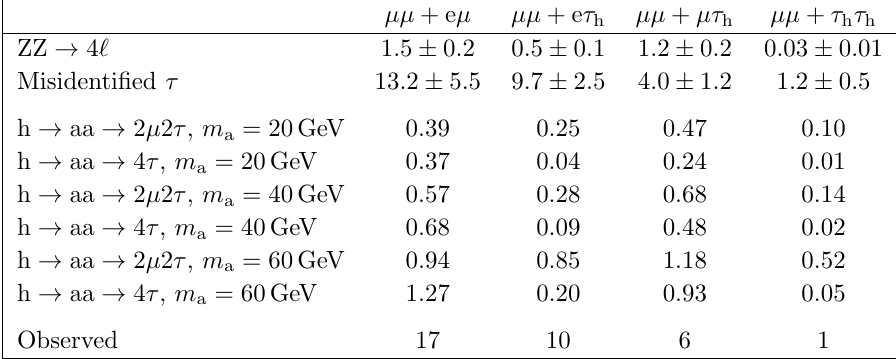
Table 1 . Yields of the signal and background processes in the four (cid:12)nal states, as well as the number of observed events in each (cid:12)nal state, in the dimuon mass range between 14 and 64 GeV. The signal yields are given for B (h ! aa ! 2 (cid:22) 2 (cid:28) ) = 0 : 01%. The h ! aa ! 4 (cid:28) signal is scaled assuming the couplings of the pseudoscalar boson proportional to the squared lepton mass, as in eq. (1.1). The production cross section of the Higgs boson predicted in the SM is assumed. The uncertainties combine the statistical and systematic sources.